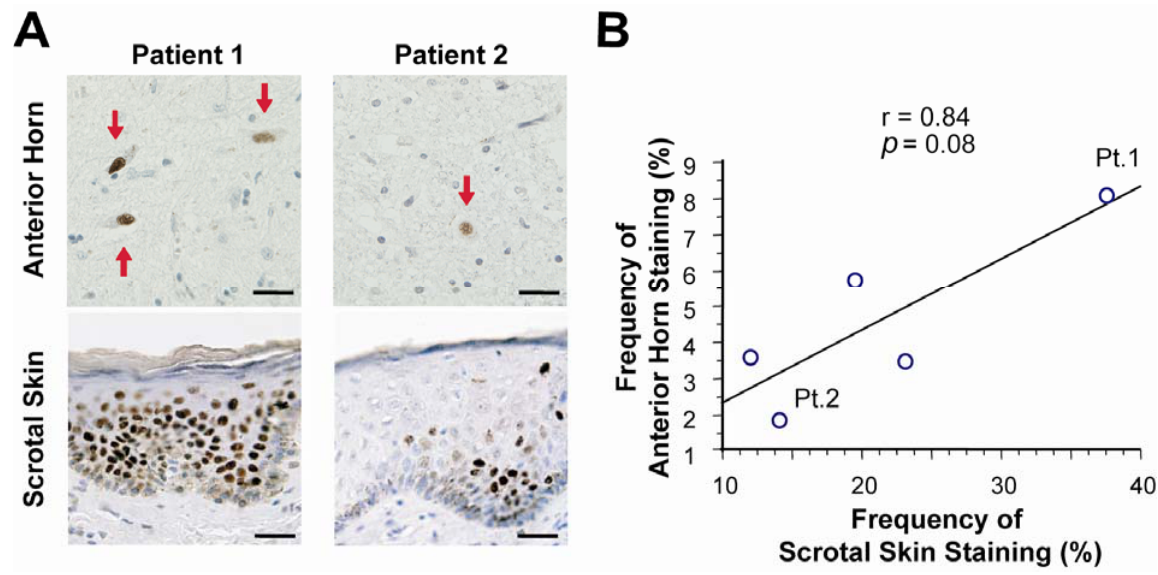
Figure 2. Mutant AR nuclear accumulation in scrotal skin and spinal motor neurons. (A) Mutant AR accumulation was remarkable in both spinal motor neurons and scrotal skin of Patient 1, but less remarkable in both motor neurons and skin in Patient 2. Scale bar = 30 µm. (B) The extent of mutant AR accumulation in scrotal skin epithelial cells showed a tendency to correlate with that in anterior horn